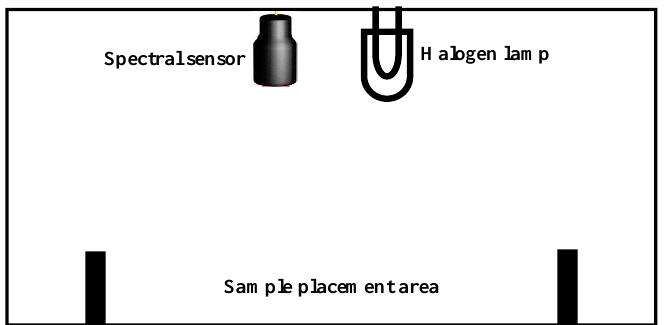
Figure 2. Structure diagram of the sample chamber unit.